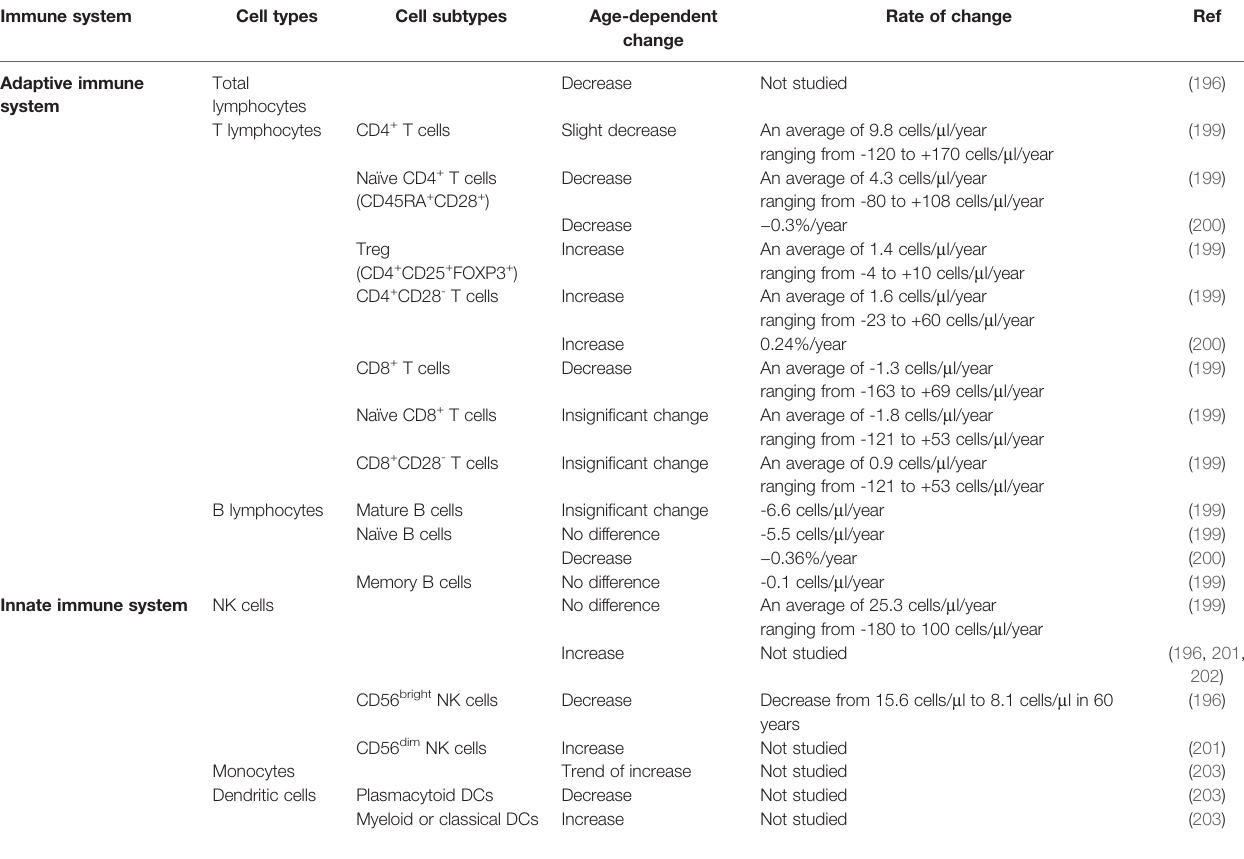
TABLE 2 | Age-dependent changes in the population of immune cell